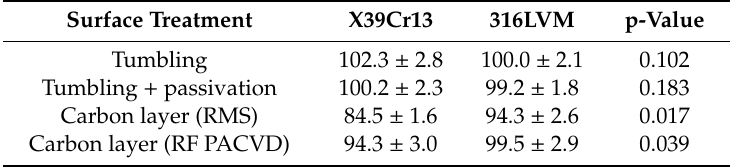
Table 7. Results of contact angle θ [ ◦ ] measurements of the analyzed materials.